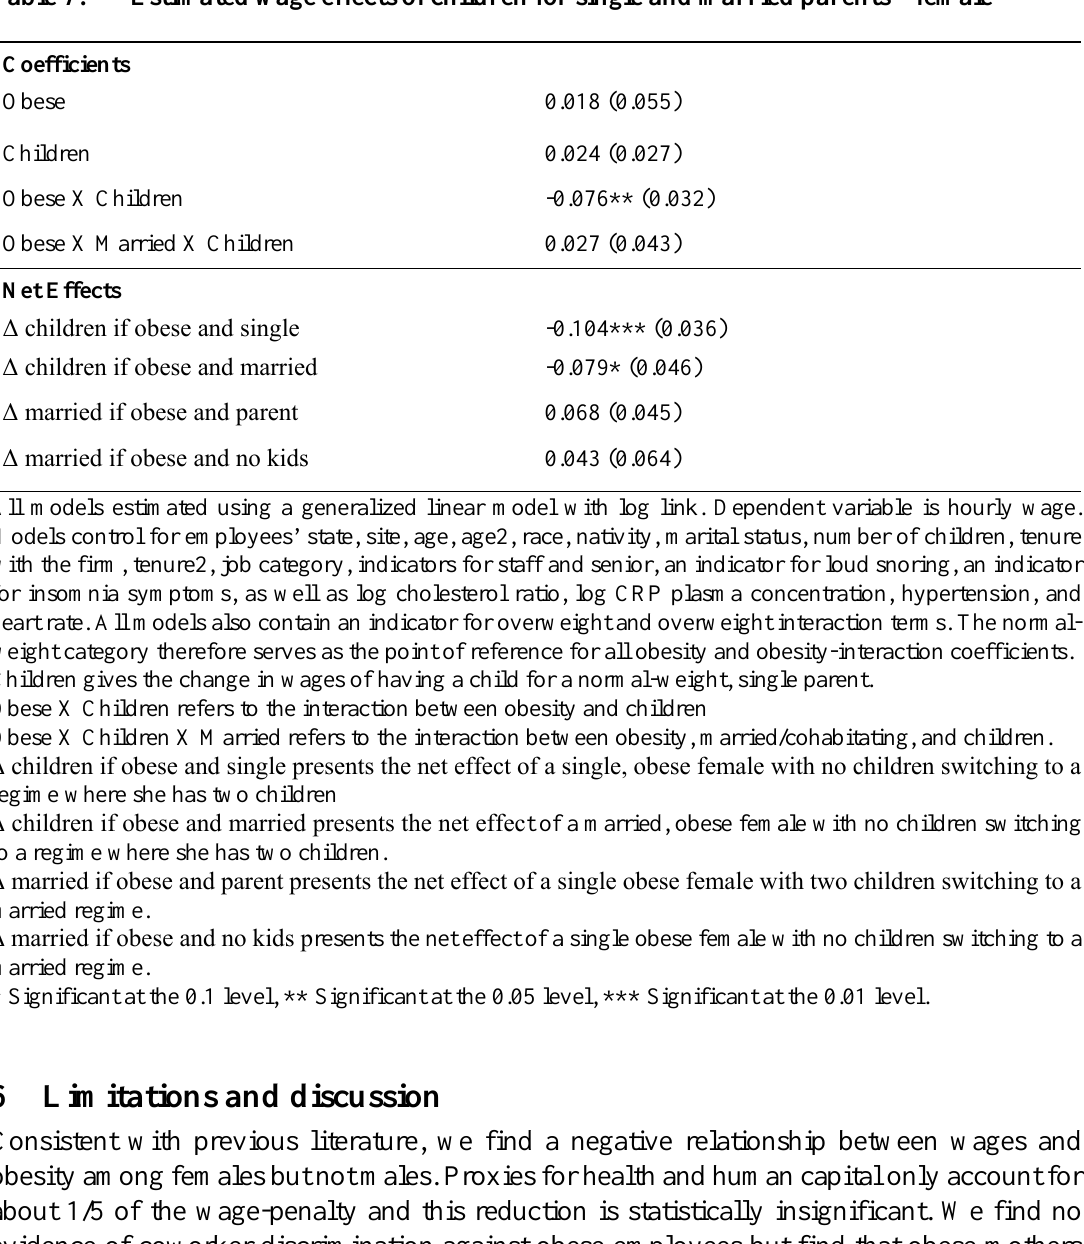
Estimated wage effects of children for single and married parents –